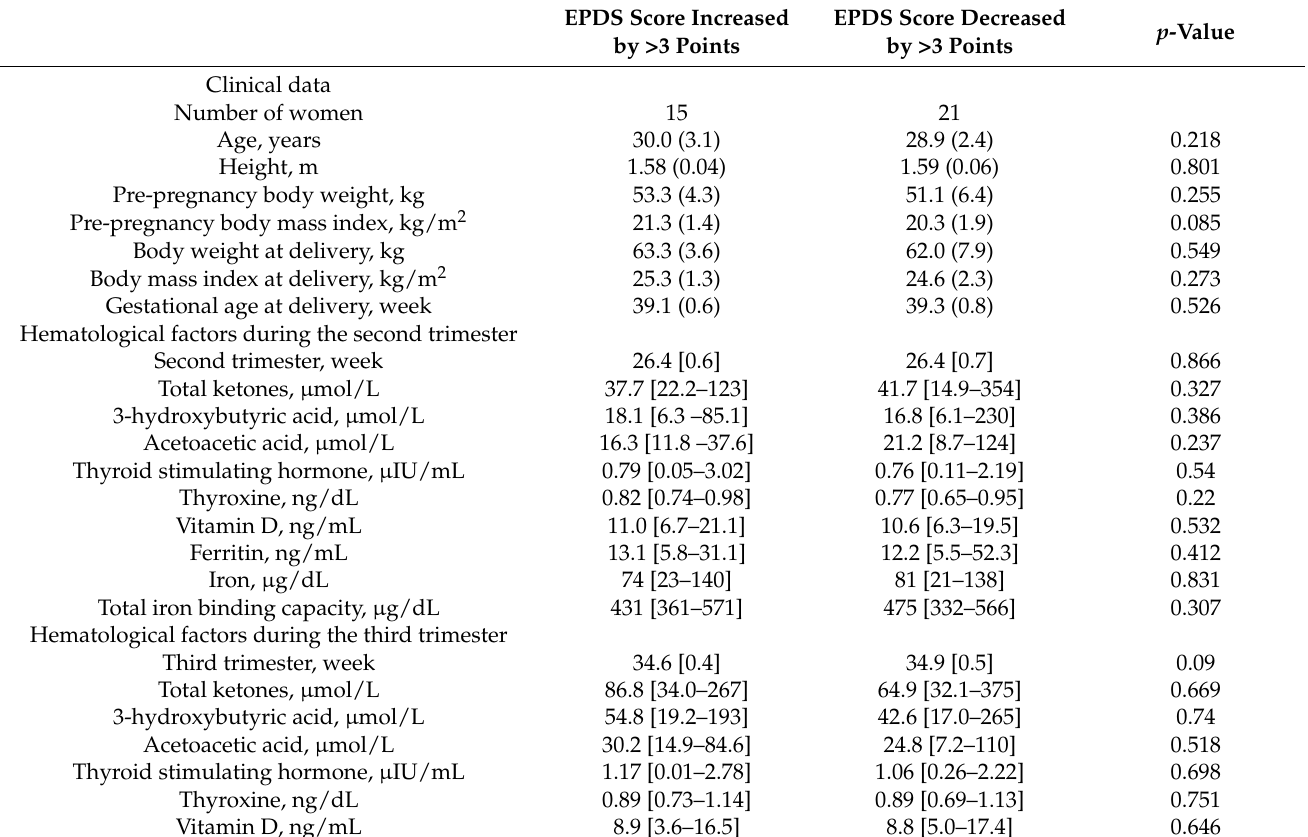
Table 5. Comparison of the EPDS score increased and decreased groups from 3 days to 1 month